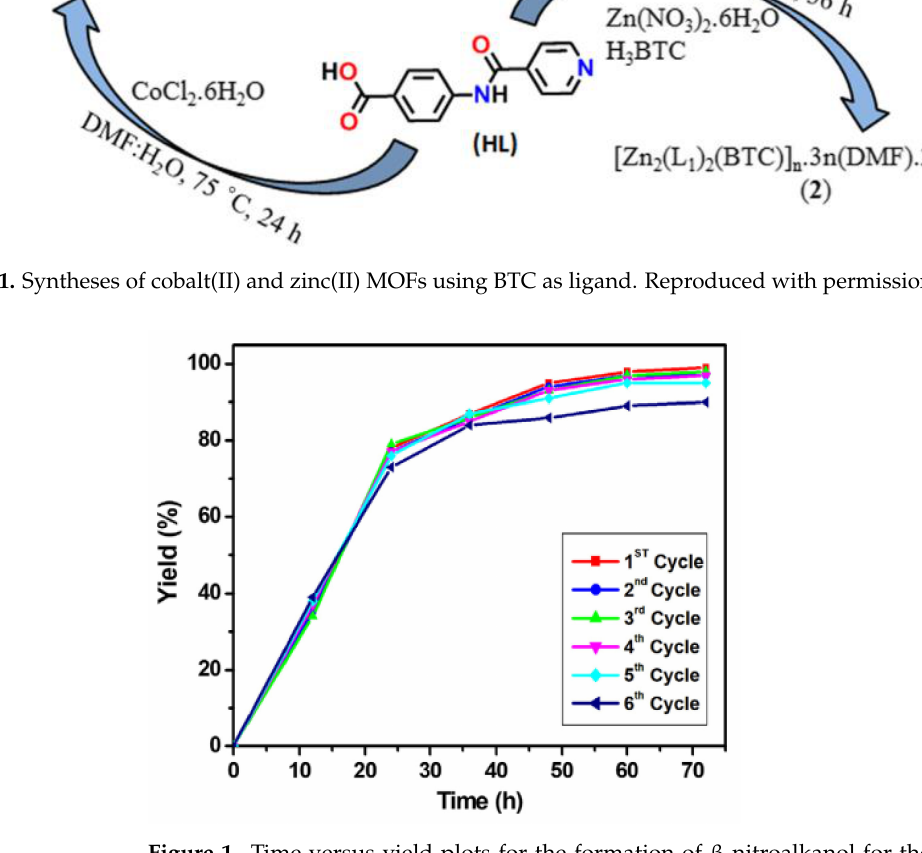
Figure 1. Time versus yield plots for the formation of β -nitroalkanol for the Henry coupling of benzaldehyde with nitroethane. Reproduced with permission from